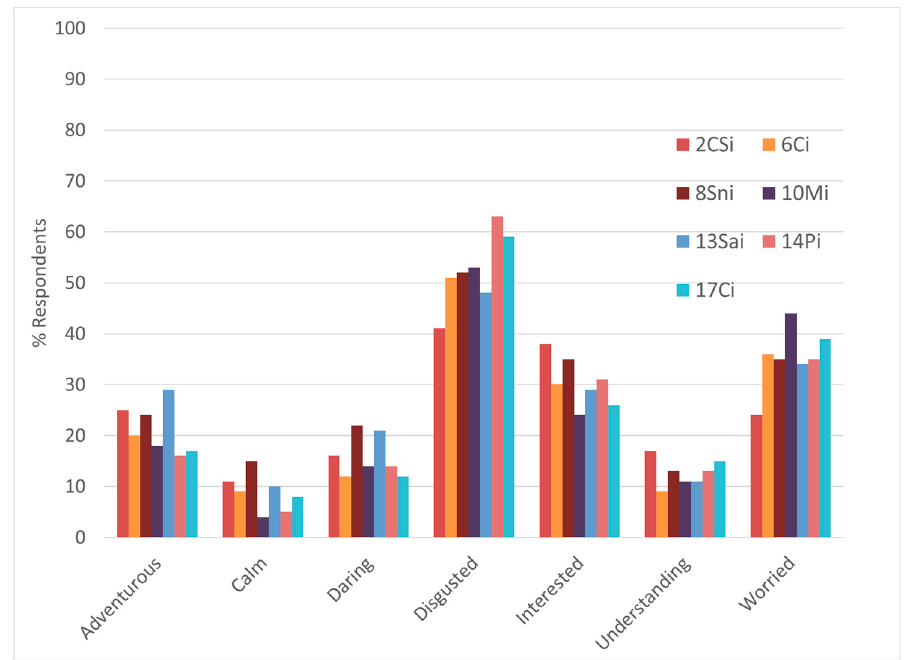
Figure 9. Estimated percentages of respondents considering the emotions for which either the Sustainability Information or the Product Category had a significant effect, and the treatments for which only the Insect Presence Information were given, and the treatment 2CSi. Treatment abbreviations can be found in Table 1.